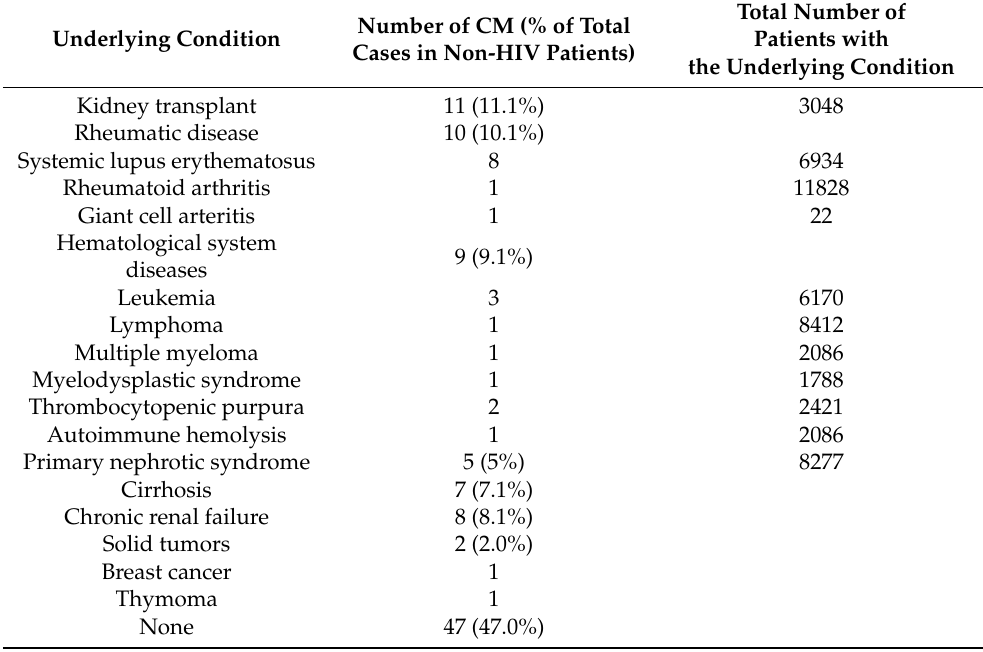
Table 2. Main underlying conditions in 99 consecutive cases of cryptococcal meningitis (CM) in non-HIV-infected patients, and the number of patients hospitalized with this condition (2010–2021).